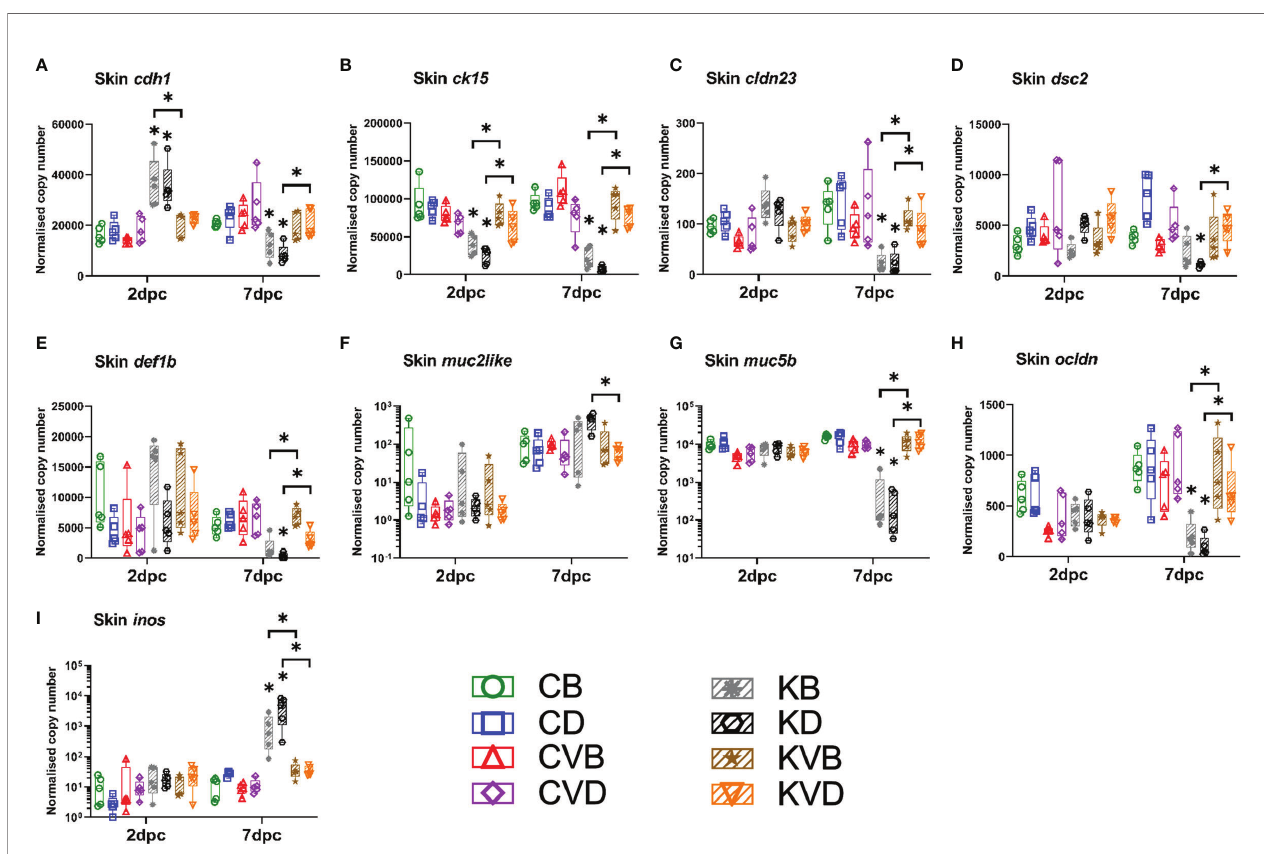
FIGURE 7 | Level of transcripts coding for proteins involved in skin barrier integrity and function after the CyHV-3 challenge at 2 dpc and 7 dpc measured with RT- qPCR: (A) cdh1 , (B) ck15 , (C) cldn23 , (D) dsc2 , (E) def1b , (F) muc2like , (G) muc5b , (H) ocldn , (I) inos . The description of experimental groups: CB – BSA, non- vaccinated, unchallenged control, CD – defensins, non-vaccinated, unchallenged control, CVB – BSA, vaccinated, unchallenged control, CVD – defensins, vaccinated, unchallenged control, KB - BSA non-vaccinated, CyHV-3 challenged, KD – defensins non-vaccinated, CyHV-3 challenged, KVB – BSA, vaccinated, CyHV-3 challenged, KVD – defensins, vaccinated, CyHV-3 challenged. The results are presented as 25%-75% box plots with min. and max. values as whiskers with indication of all data points. The data are shown as normalised copy numbers. * indicates statistical signi fi cant difference at p < 0.05. Statistical analysis was performed with two-way ANOVA with multiple comparisons test performed with the Holm-Sidak